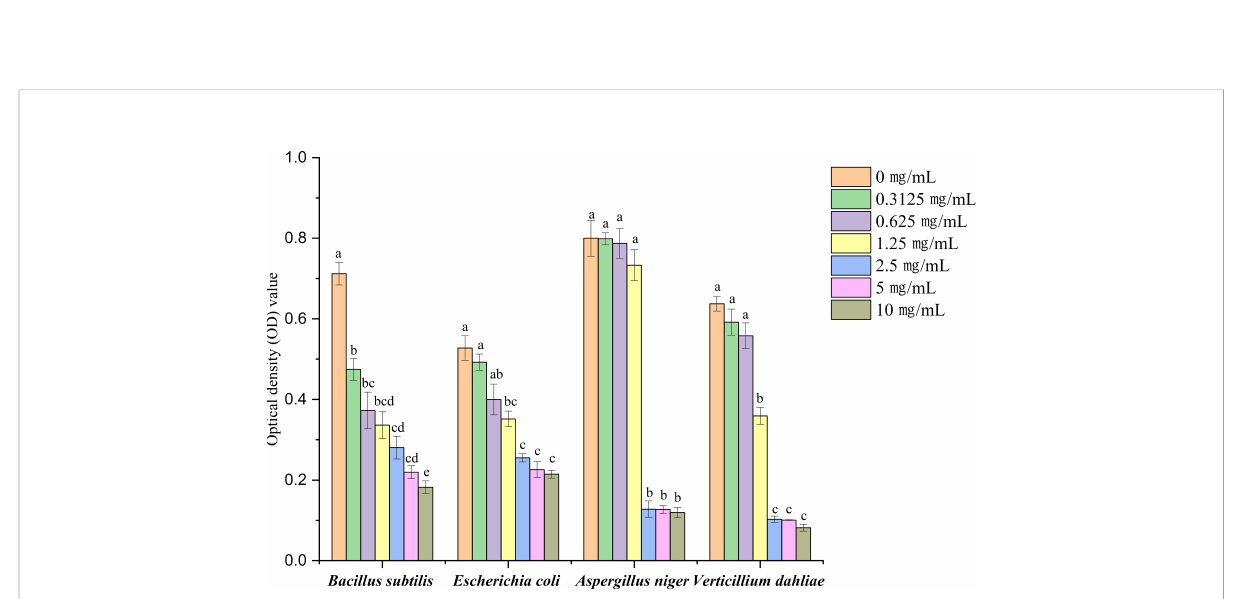
FIGURE 5 The optical density (OD) value on antimicrobial activity of A. tibetica EO. Different letters indicated signi fi cant differences ( P < 0.05) level according to Fisher ’ s LSD